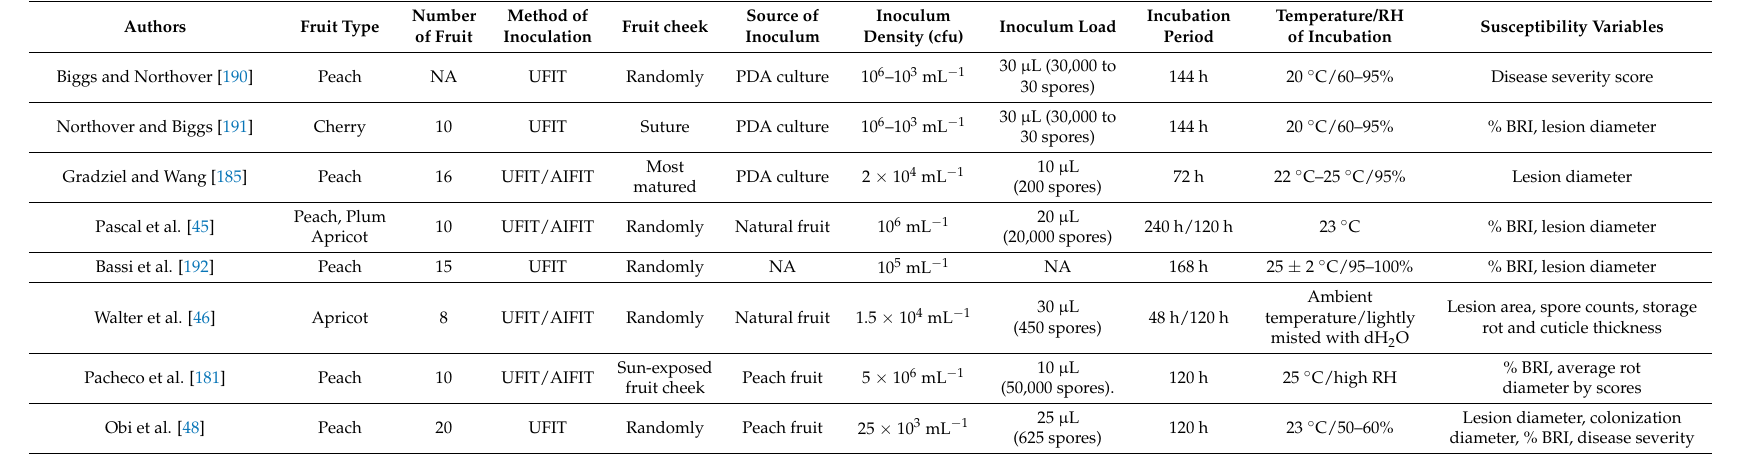
Table 7. Assessment conditions to screen ex situ brown rot ( Monilinia spp.) susceptibility in stone fruits. References, host inoculation, spores production, and parameters